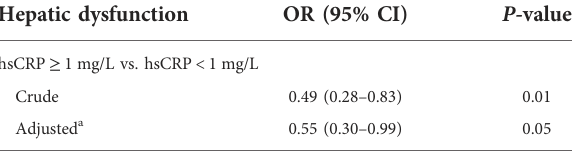
TABLE 5 Association of hsCRP with hepatic dysfunction. Hepatic